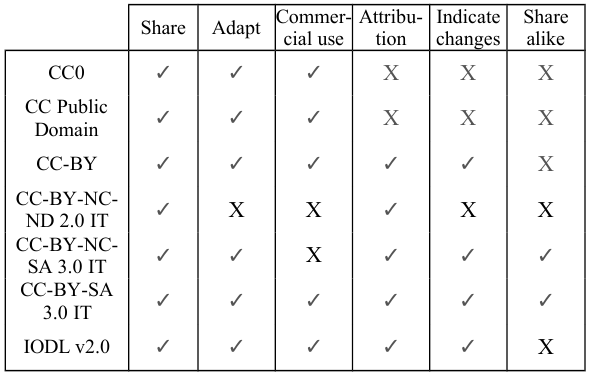
Table 1. Differences between the permissions ensured by the licenses of the available open geodata for Milan Municipality